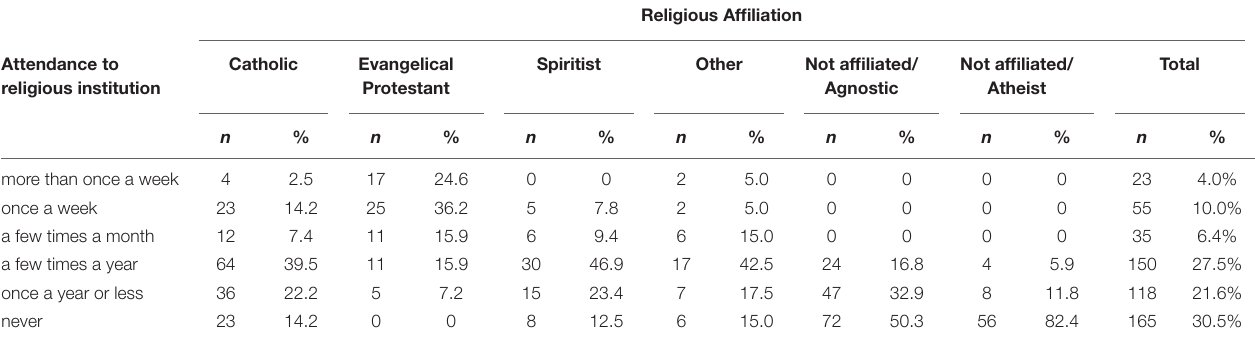
TABLE 3 | Attendance to religious institution by students from different religious